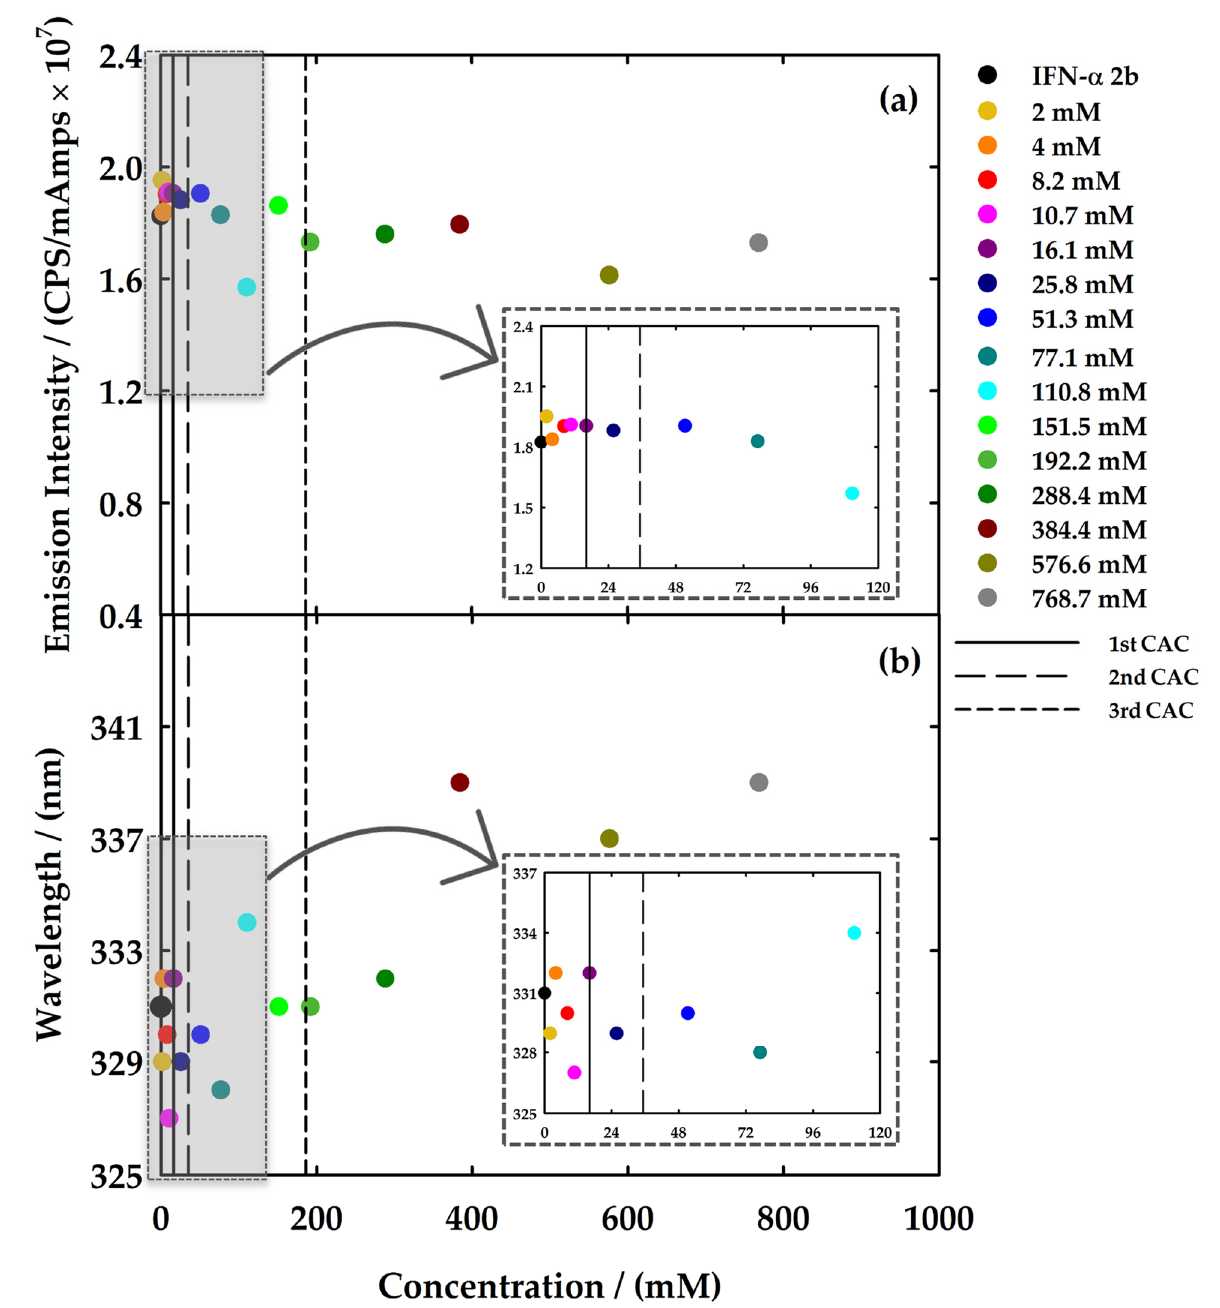
Figure 7. ( a ) Emission intensity and ( b ) wavelength variation of the maximum of the emission spectra of different concentrations of [N 1112(OH) ][C 4 F 9 SO 3 ] with IFN- α 2b at 20 µ g/mL recorded at 280 nm. All samples were prepared in 5 mM NaH 2 PO 4 (pH = 7.4) and measured at 25 °C. Analysing both systems, a decrease in the intensity in the region between ~14 mM and ~110 mM (above the 1st CAC) was found, which was more pronounced for [C 2 C 1 Im][C 4 F 9 SO 3 ], which is called the quenching effect. A very well-known equation, the Stern–Volmer, was used to characterize the quenching occurring in this region. This equation characterizes the collisional quenching that can occur when the excited state of the fluorophore is disabled due to contact with another molecule (quencher), without chemi- cal alteration [61]. Therefore, the collisional quenching is described by: